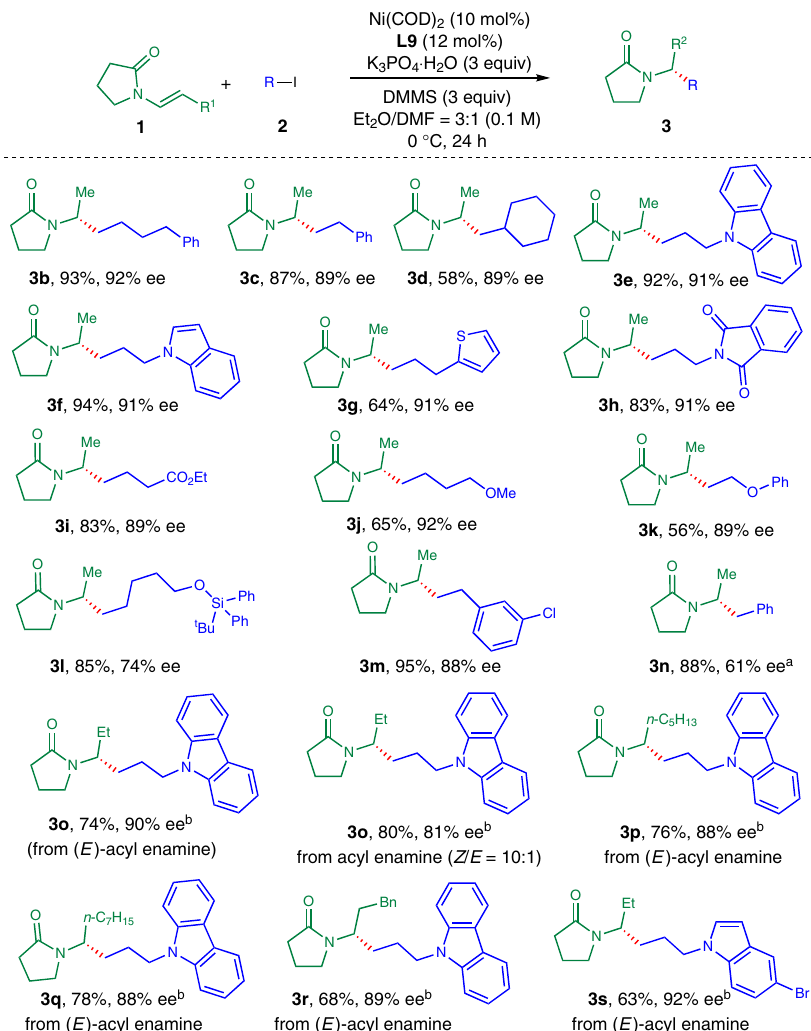
Fig. 2 Scope for alkyl iodides of tertiary acyl enamines and internal acyl enamines. For reaction conditions, see Table 1, entry 19 unless otherwise stated. a Benzyl bromide was used. b The reaction was conducted using 1 (0.2 mmol), 2 (0.6 mmol) at 45 °C for 16